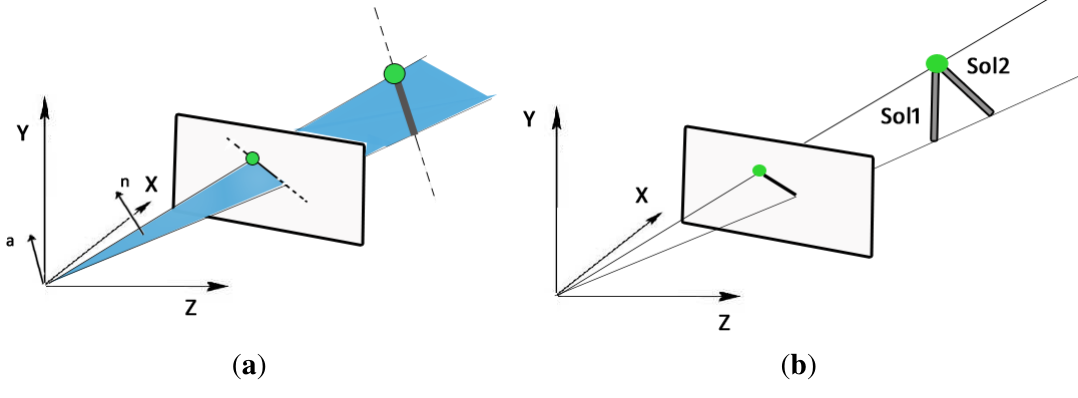
Figure 5. Methods to compute the orientation of the light emitter. ( a ) Method based on the plane defined by the laser and one endpoint; ( b ) Method based on the extraction of the laser endpoint and known